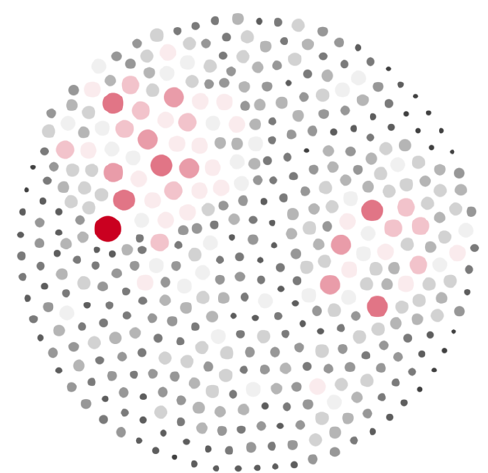
Figure 4. A demo of group relationship.